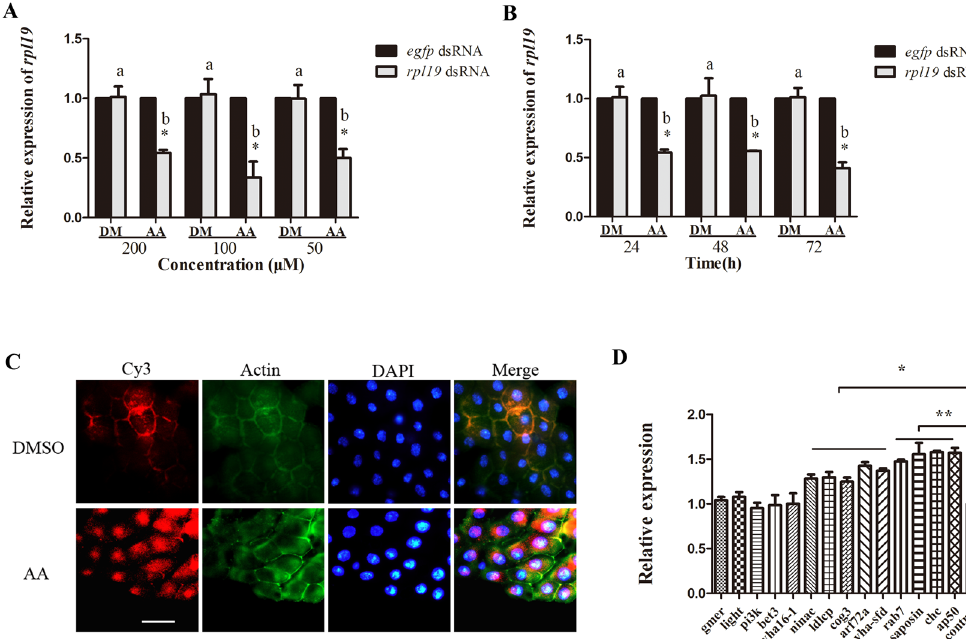
Figure 3. Rescue the RNAi effect in Ch flies by injectiing arachidonic acid. (A) mRNA accumulation of the target gene after feeding ds- rpl19 in flies from the Ch group followed by injection of AA at different concentrations. (B) mRNA accumulation of the target gene in flies from the Ch group after feeding ds- rpl19 for different time durations followed by injection of AA. (C) Subcellular localization of Cy3-labelled ds- rpl19 in midgut tissue of B. dorsalis after injecting AA into the Ch flies. The scale bar represents 25 μ m. (D) Expression levels of genes required for the endocytic entry of dsRNAs after injecting AA. Normalized target gene mRNA accumulation is reported relative to the mRNA accumulation in the ds- egfp control, which was set to 1. All error bars represent the S.E. of the mean of three independent biological replicates. * indicates a statistically significant difference in rpl19 mRNA accumulation between the feeding ds- rpl19 group and the control ds- egfp group (P < 0.05). ** indicates P < 0.01 (Student’s t-test). Different letters indicate a significant difference in rpl19 mRNA accumulation among the feeding ds- rpl19 treatments (P < 0.05, Duncan’s